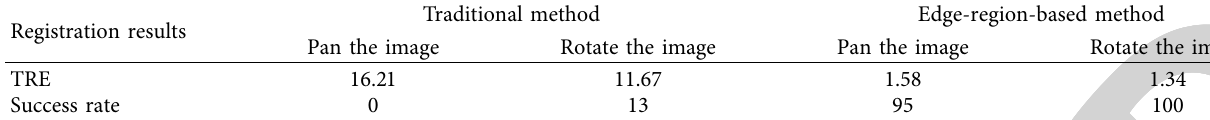
Table 8: Comparison results with traditional methods.